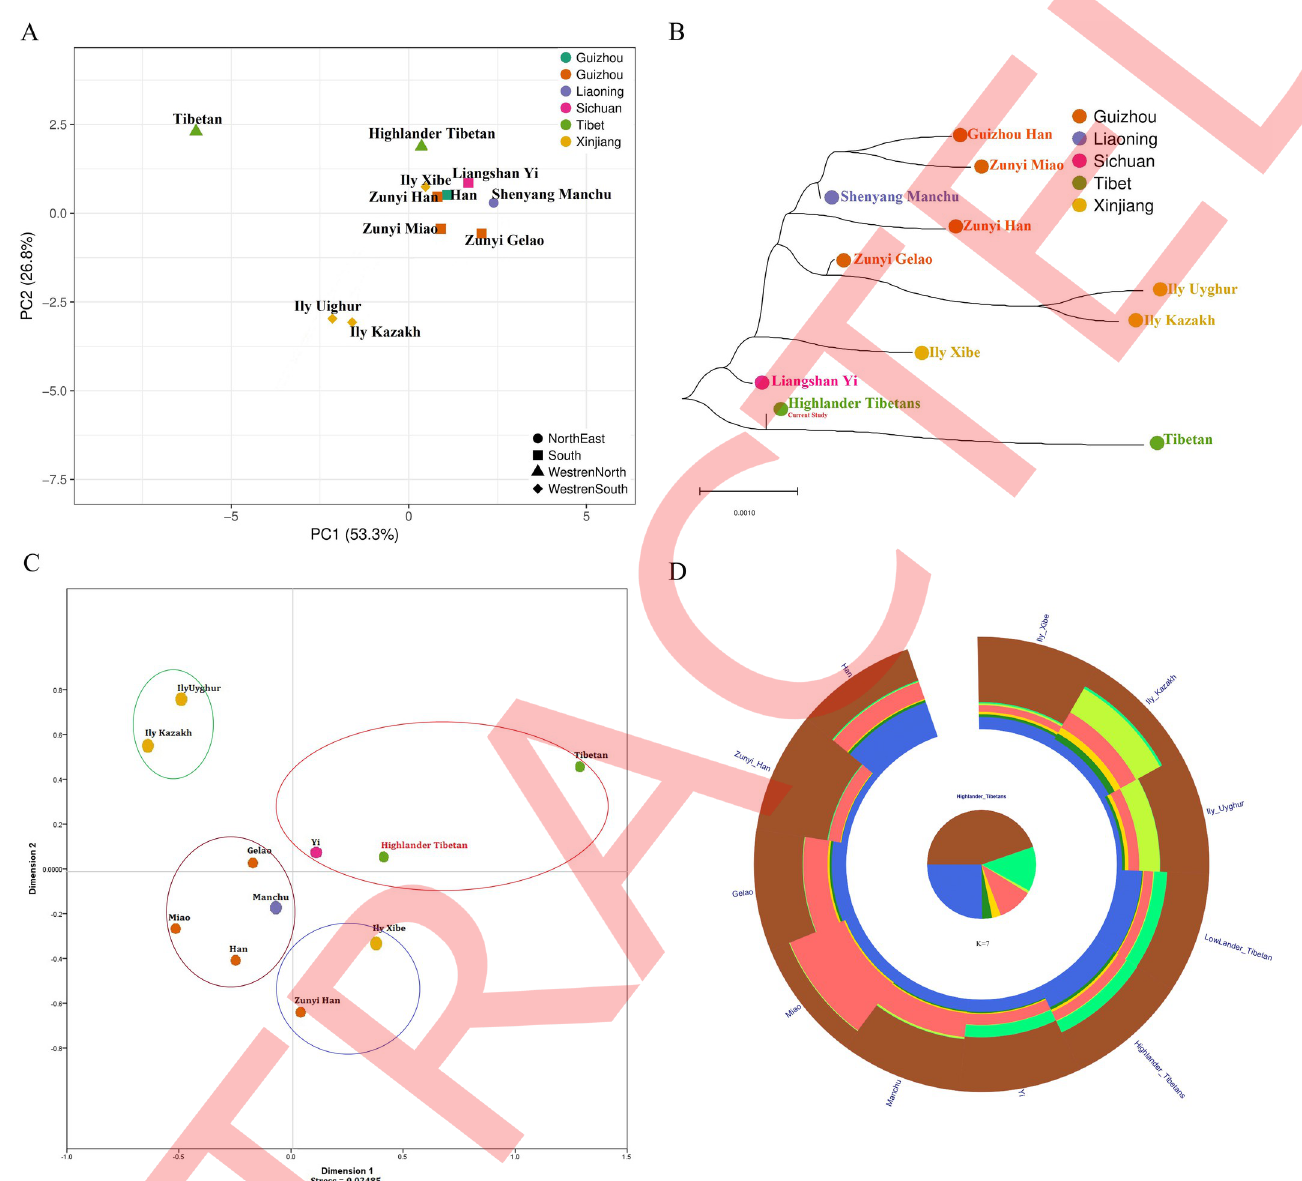
Fig 2. Genetic structure and population relationship between Highlander Tibetan and other 10 populations; (A) Principal component analysis (PCA) revealed the genetic relationship on the basis of the first two components; (B) A two-dimensional scaling (MDS) plot of the Highlander Tibetan and other 10 populations; (C) A Neighbor-Joining tree explaining the phylogenetic relationship of Highlander Tibetan; (D) Genetic structure revealed by Structure from Highlander Tibetan female samples. best optimal predefined populations in seven (K = 7). We have observed consistent brown pink and blue common component among all populations. In Highlander Tibetans, we have observed 4 major components which are brown pink, blue and light green while a small por- tion of yellow and dark green. The only green component was present in Tibetans and Yi while the parrot green component was only present in Kazakhs and Uighurs. Green compo- nent was present in Highlander Tibetans while it was absent in Tibetans. One of the most diffi- cult environmental stressors on human populations is altitude. Highlanders from Asia,